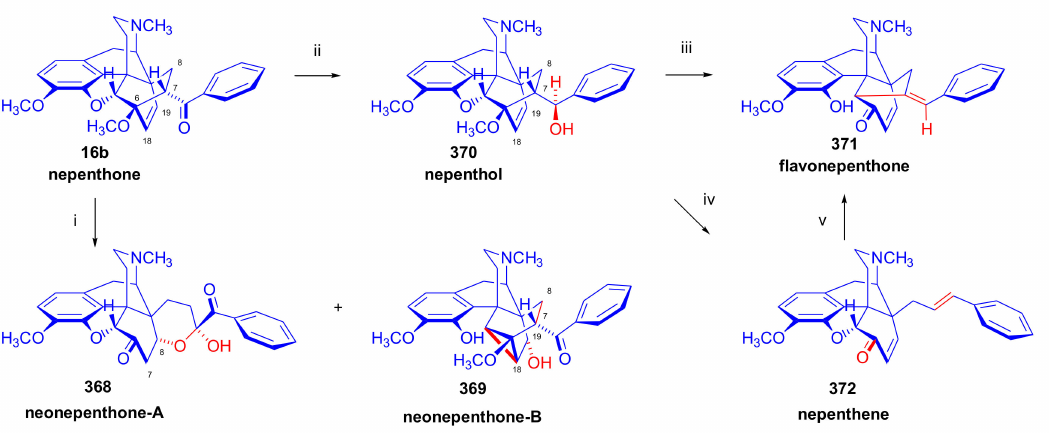
Figure 94. Acid-catalyzed rearrangement of nepenthone and its derivatives. Reagents and conditions : (i): 1:1 ( v/v ) cc. hydrochloric acid, glacial acetic acid, 100 ◦ C, 6 h; (ii): aluminum isopropoxide, 2-propanol, reflux, 84%; or NaBH 4 , methanol, 30%; (iii): 1:1 ( v/v ) cc. hydrochloric acid, glacial acetic acid, 100 ◦ C, 1 h, 84%; (iv): formic acid, reflux, 16 h, 76%; and (v): 1:1 ( v/v ) cc. hydrochloric acid, glacial acetic acid, 100 ◦ C, 6